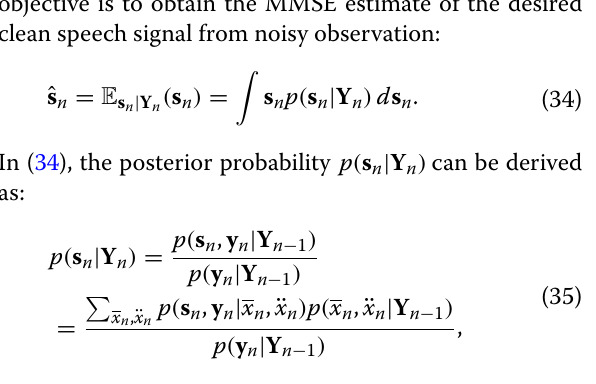
algorithm in the proposed NMF-HMM model.